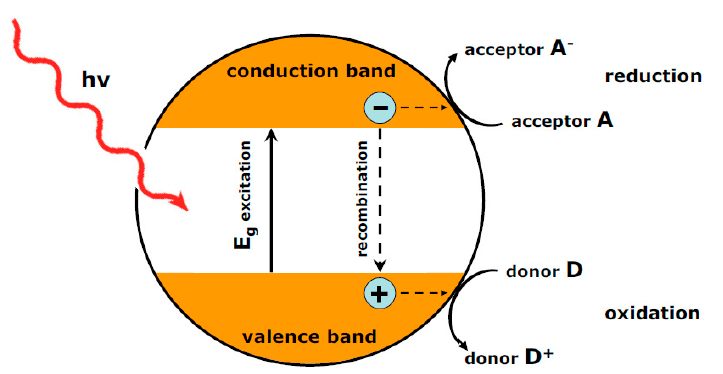
Figure 9. Schematic illustration of a photocatalytic effect on the surface of a